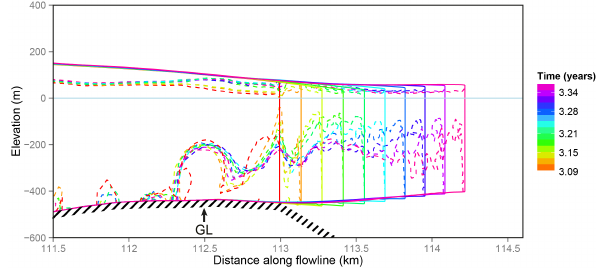
Figure 7. Sequential profiles of Store Glacier during advance of its calving terminus due to mélange backstress. As the floating tongue advances from the grounding line (marked GL), it rises upwards due to buoyant forces, which also act to close surface crevasses near the grounding line. This indicates that flow dynamics at the grounding line are forcing the terminus below flotation.